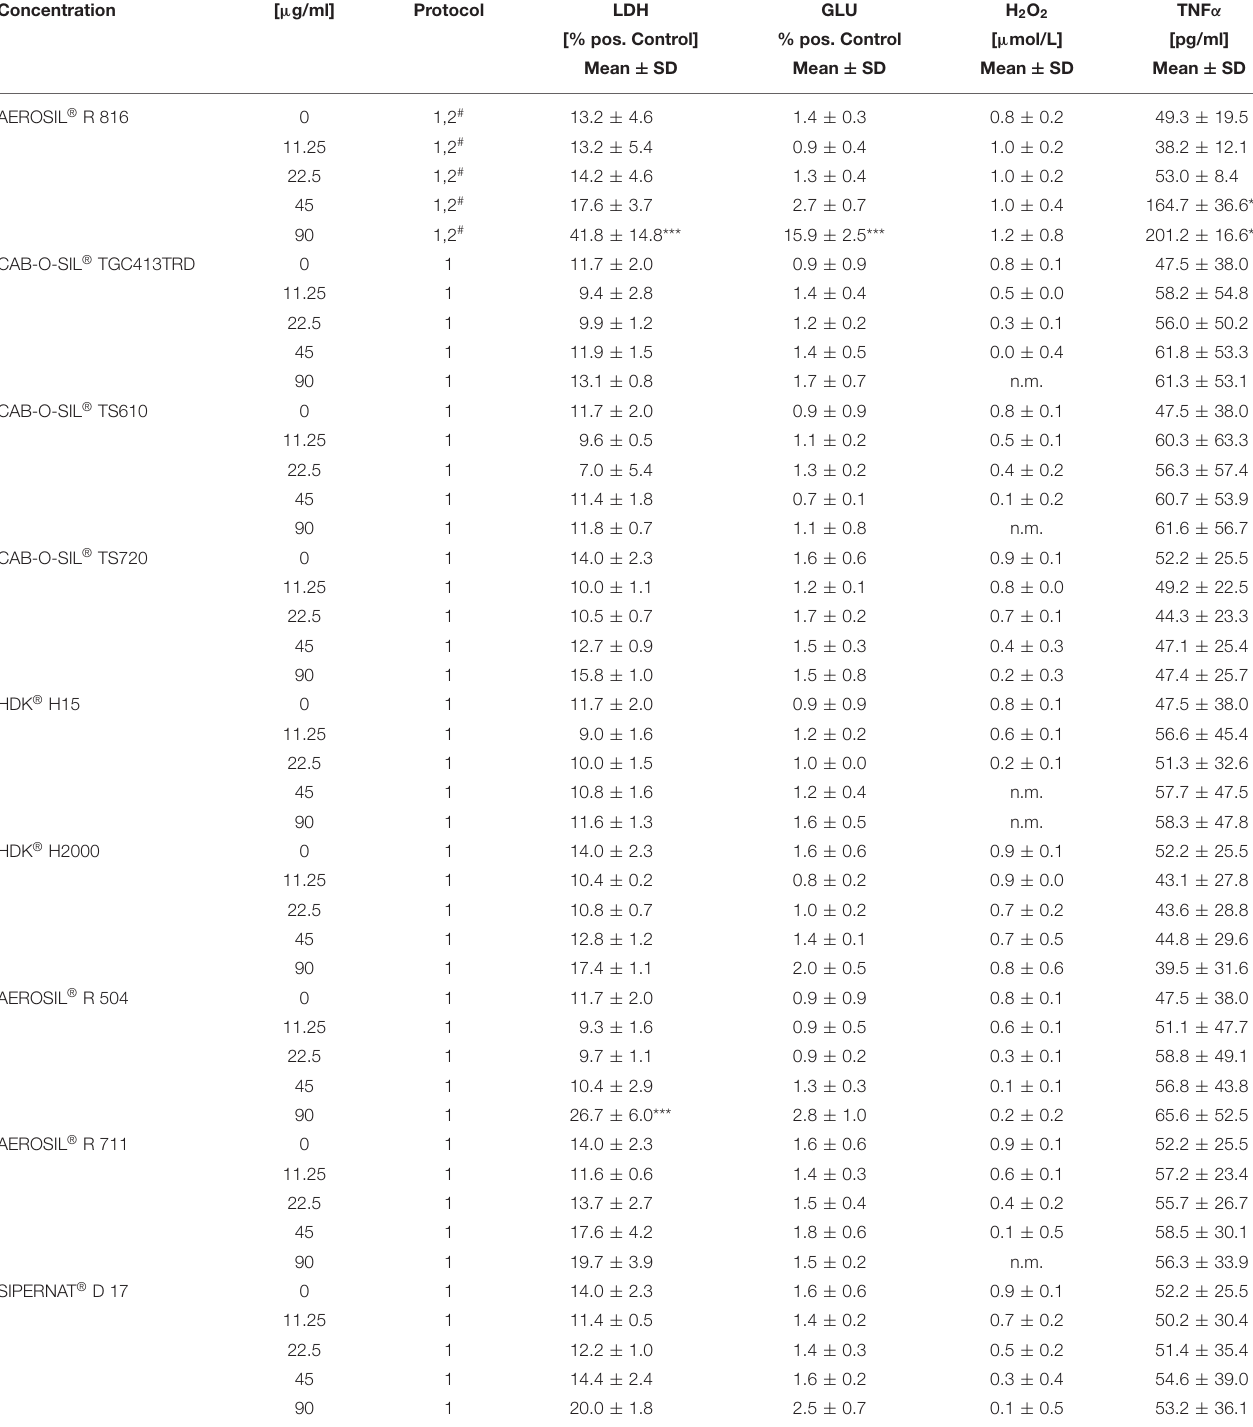
TABLE 5 | Effects of surface-treated SAS on NR8383 cells.